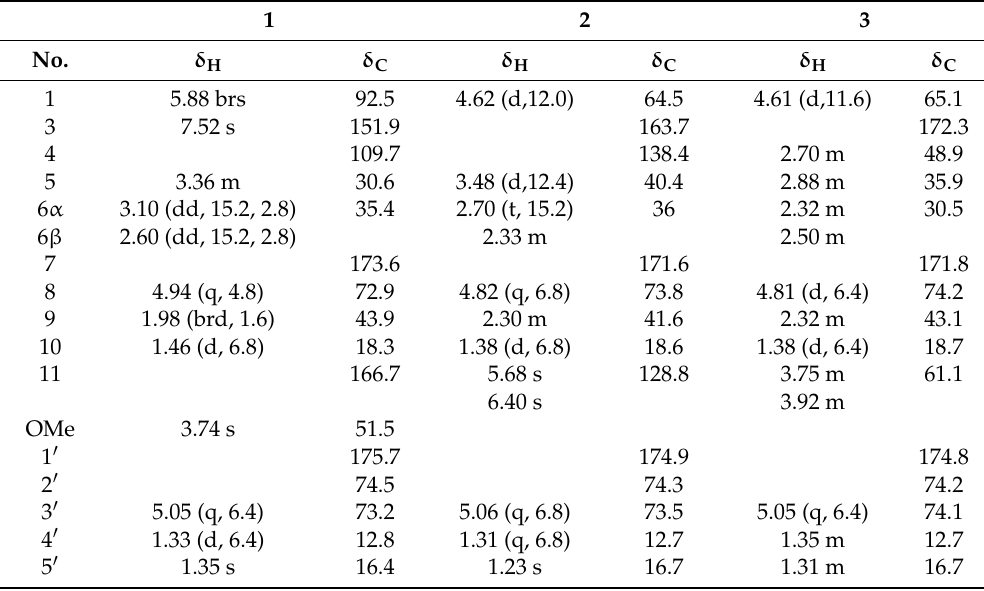
Table 1. 1 H-NMR and 13 C-NMR data for compounds 1 − 3 a